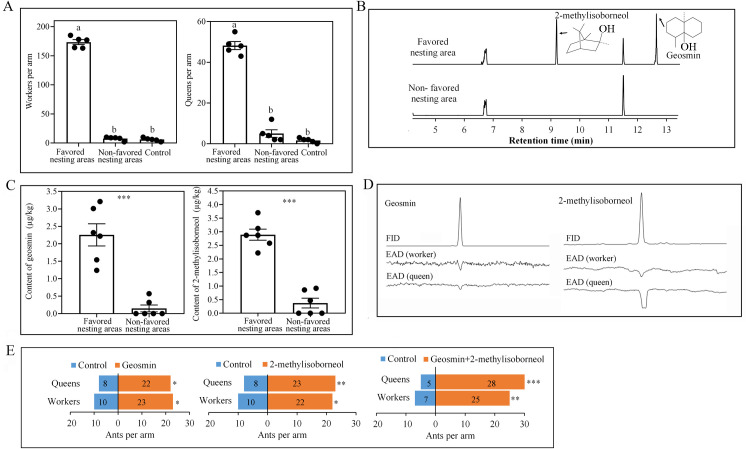
Attraction of S. invicta to soil from favored nesting areas and to soil volatiles.(A) Choices of workers and queens in regard to soil from favored or non-favored nesting areas in olfactometer bioassays (±SE, n = 5 biological replicates). Control: empty arm. (B) Typical gas chromatographic traces obtained from the soil of favored and non-favored nesting areas. (C) Content of geosmin and 2-methylisoborneol (±SE, n = 6 biological replicates, independent sample t test). (D) GC−EAD profile of geosmin and 2-methylisoborneol on worker and queen antenna. Upper trace: GC−FID. Lower trace: EAG (unit: mV). (E) Attraction of S. invicta to geosmin and 2-methylisoborneol in a Y-tube olfactometer (n ≥ 30 biological replicates, chi-square test). Control: mineral oil. Different letters above bars indicate significant differences according to Kendall’s W test at the 0.05 level. Asterisks indicate significant differences (*P < 0.05, **P < 0.01, *** P < 0.001).